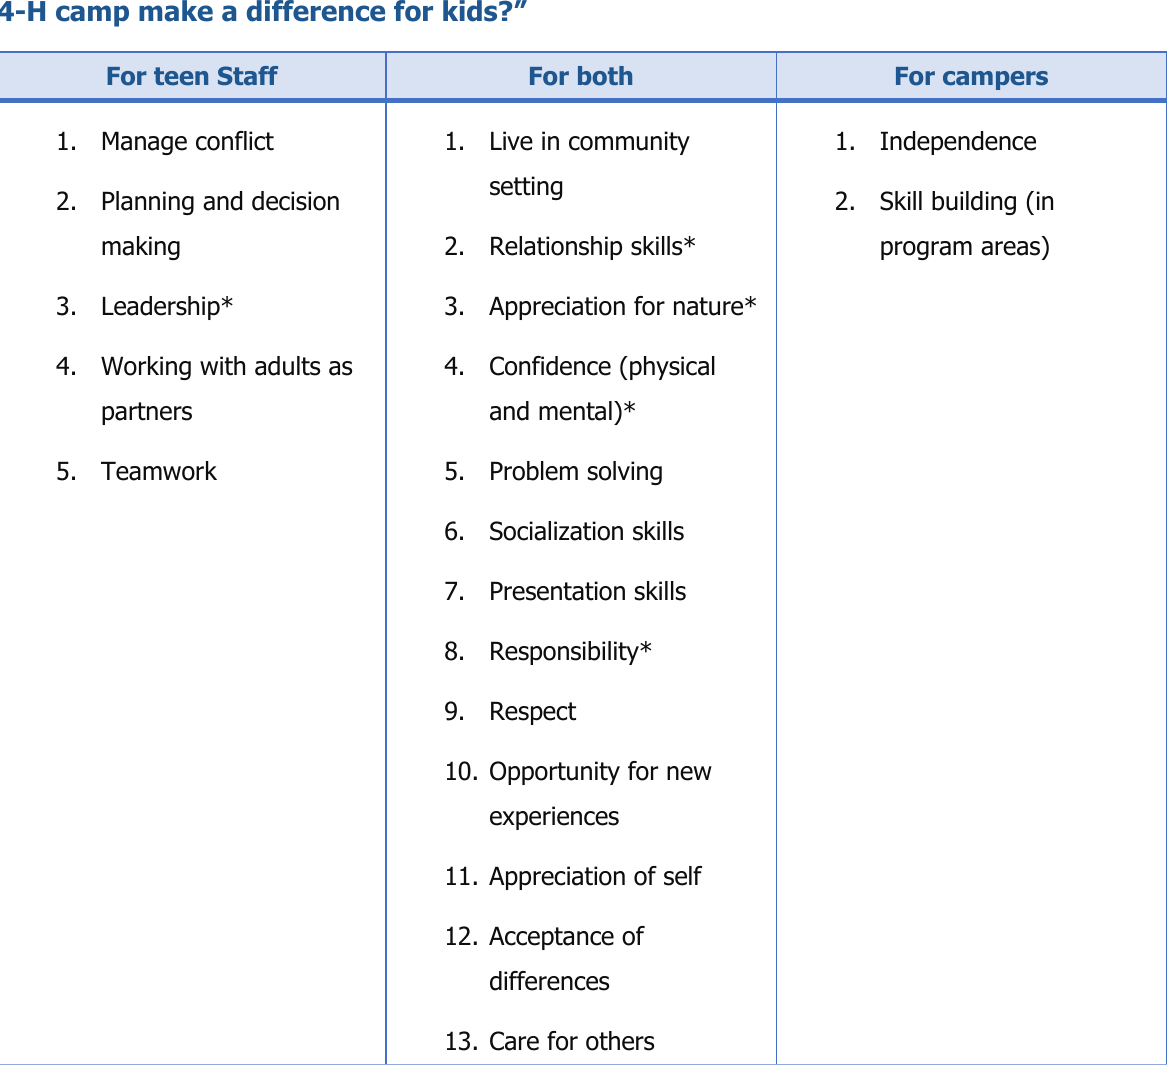
Table 1. 4-H Camping Advisory Committee Responses to the Question “How does 4-H camp make a difference for